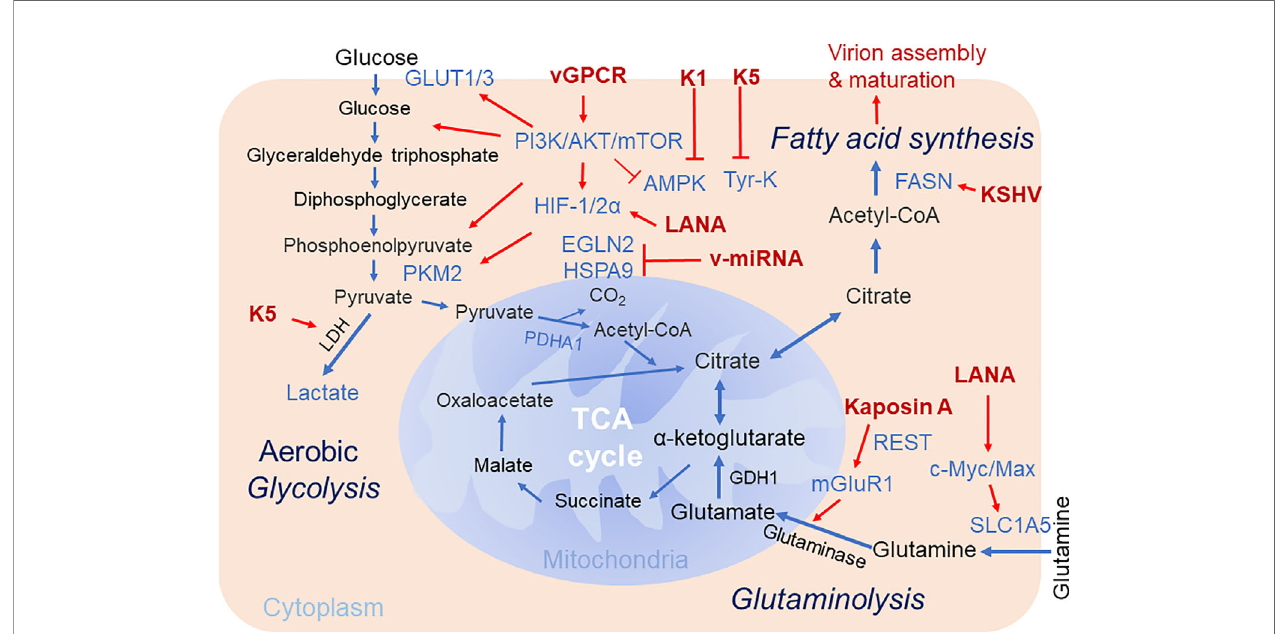
FIGURE 1 | Brief schematics of KSHV-mediated alteration of host cellular metabolic pathways. The key steps of three cellular metabolic pathways including aerobic glycolysis, glutaminolysis and fatty acid synthesis targeted by KSHV for pathogenesis are highlighted. The increased expression of enzymes and metabolites are shown in blue. The KSHV-encoded proteins are shown in red. Red arrow denotes the regulation by KSHV. TCA Cycle, tricarboxylic acid cycle; GDH, glutamate dehydrogenase; PKM2, pyruvate kinase 2; Tyr-K, Tyrosine kinase; EGLN2, HIF prolyl hydroxylase 2; mGluR1, metabotropic glutamate receptor 1; SLC1A5, glutamine